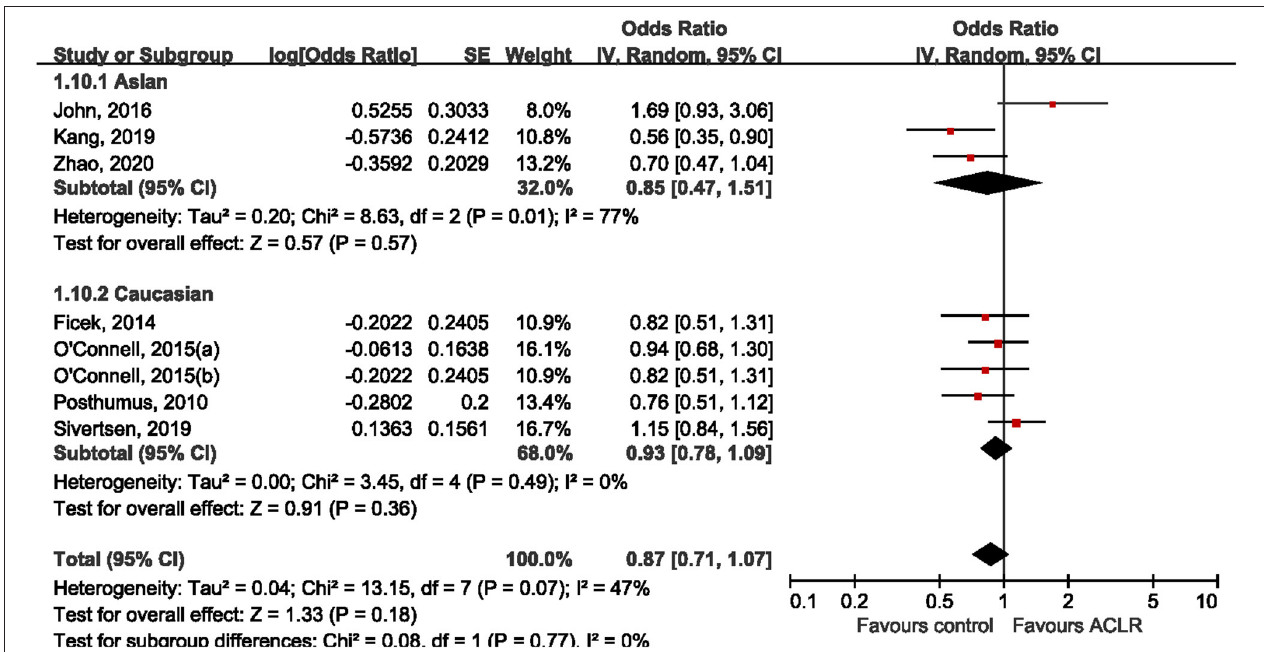
FIGURE 5 | Stratification analyses of ethnicity between rs970547 polymorphism in COL12A1 gene and ACLR risk under the allele model (A vs. G).